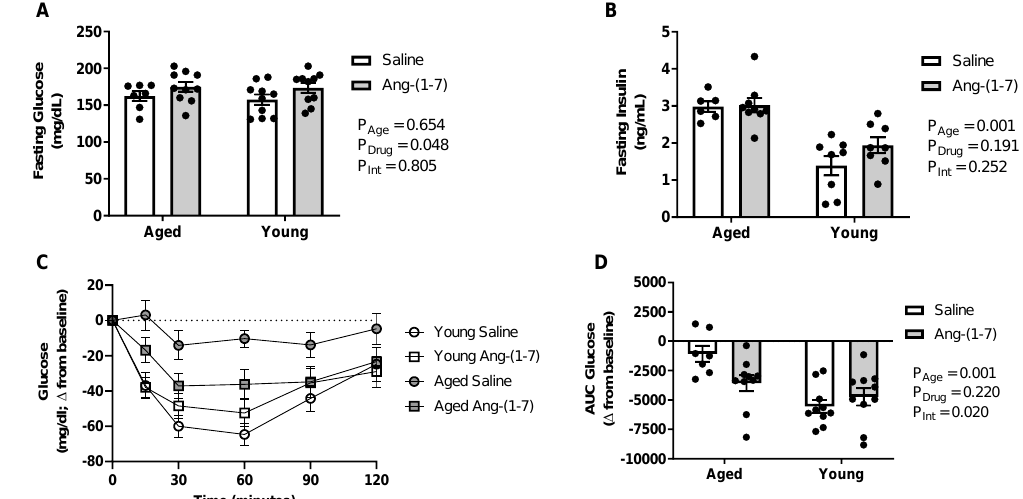
Figure 1. Angiotensin (Ang)-(1-7) improved insulin sensitivity in aged mice ( n = 8–10 / group). ( A ), Bar charts showing there was no e ff ect of aging on circulating glucose levels measured after a 4-h fasting period. The Ang-(1-7) treatment mildly elevated glucose compared with saline in young adult and aged mice. ( B ), Bar charts showing aged mice had elevated circulating insulin levels measured after a 4-h fasting period, which was not reversed by Ang-(1-7) treatment. ( C ), Raw data curve showing changes in blood glucose levels from baseline over a 120-min period following exogenous insulin administration in young adult and aged mice. Dotted line represents baseline. ( D ), Glucose data summarized as an area under the curve (AUC), with a more negative number indicating a greater drop in glucose in response to insulin or increased insulin sensitivity. Aged mice had a significant reduction in insulin sensitivity, which was improved following chronic Ang-(1-7) treatment to a similar level to that observed in young adult mice. Data are mean ± SEM and were analyzed by two-way ANOVA for main e ff ects of age (P Age ) and Ang-(1-7) versus saline treatment (P Drug ) as well as their interaction (P Int ), with Tukey post-hoc pairwise comparisons with correction for multiple comparisons.